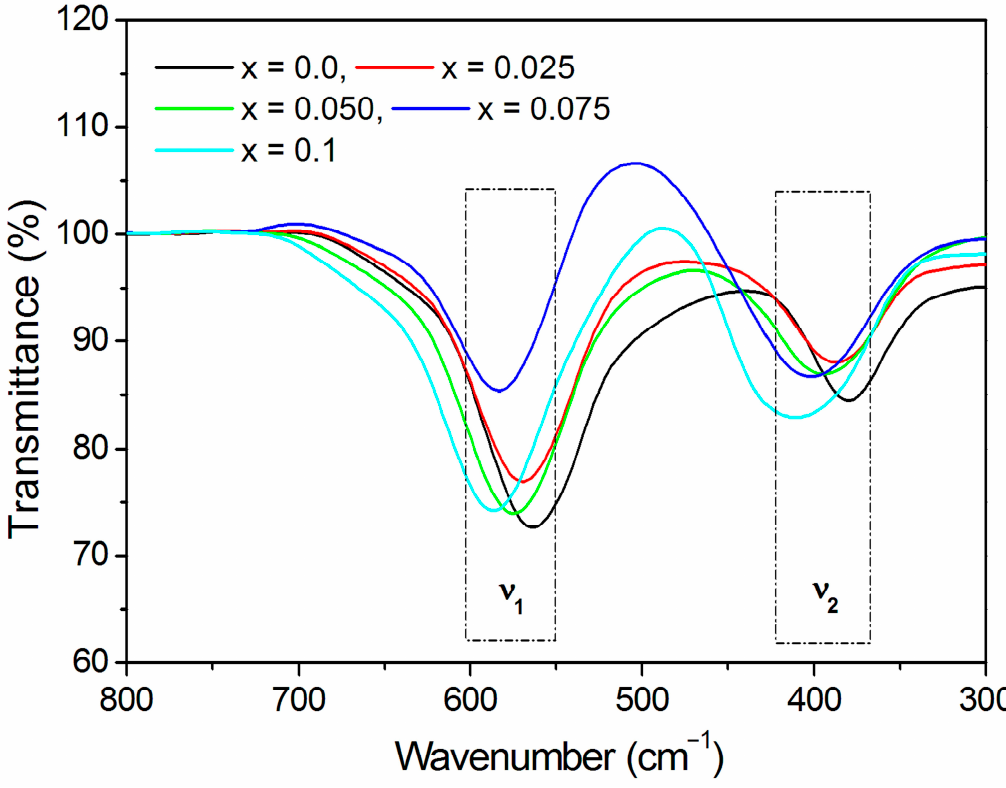
Figure 9. FTIR spectra of CoCr 0.5 Dy x Fe 1.5-x O 4 . Table 4. Elastic properties of CoCr 0.5 Dy x Fe 1.5-x O 4 . Absorption bands ( ν 1 and ν 2 ), molecular weights at